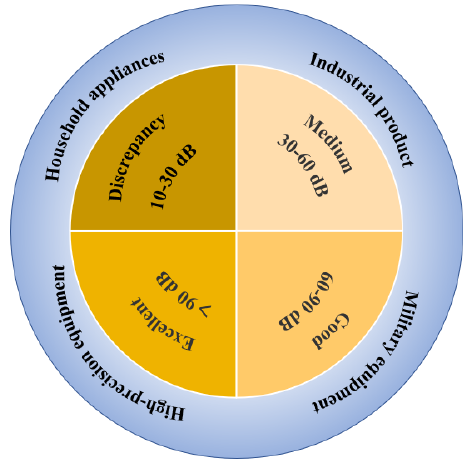
Figure 26. Classification of shielding levels.